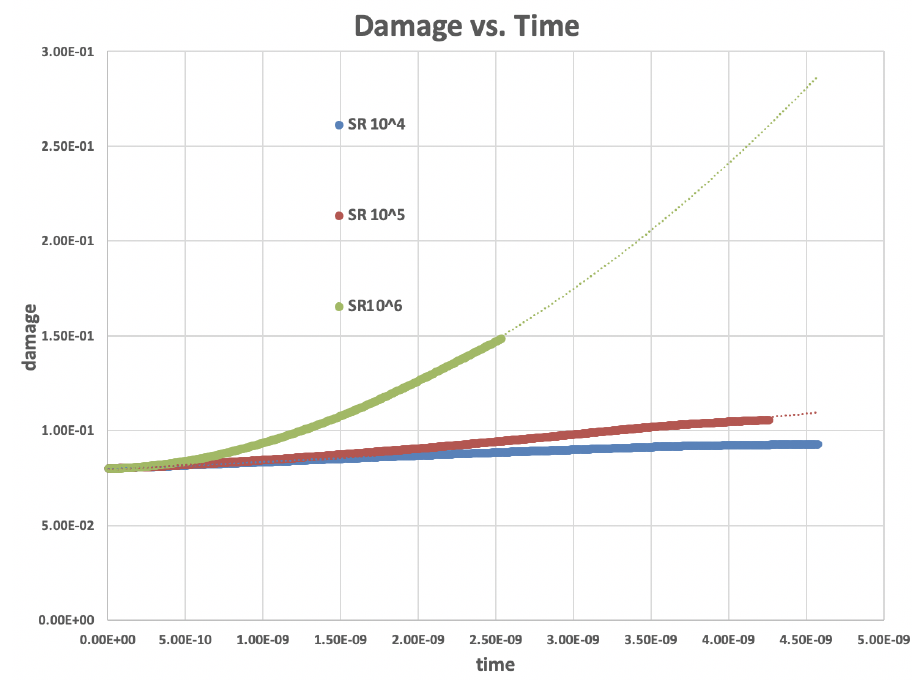
Figure 2. The ensemble-averaged damage is plotted as a function of time for 3 imposed strain rates, ˙ ϵ = 10 4 s − 1 , 10 5 s − 1 , and 10 6 s − 1 . The ensemble size is 100 and the process zone is 10% of the crack radius. The data is captured by a quadratic trendline with an R 2 > 0.995 in each case. Higher strain rates lead to shorter times to failure and more damage at time of